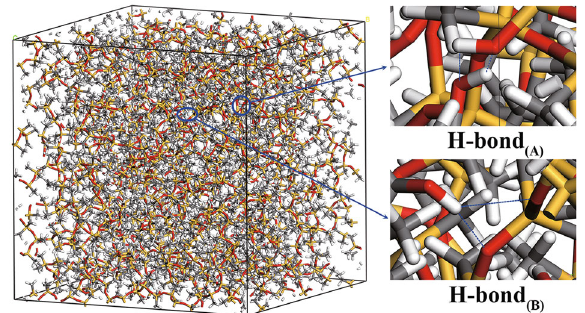
Fig. 4 The types of H-bonds in the M3